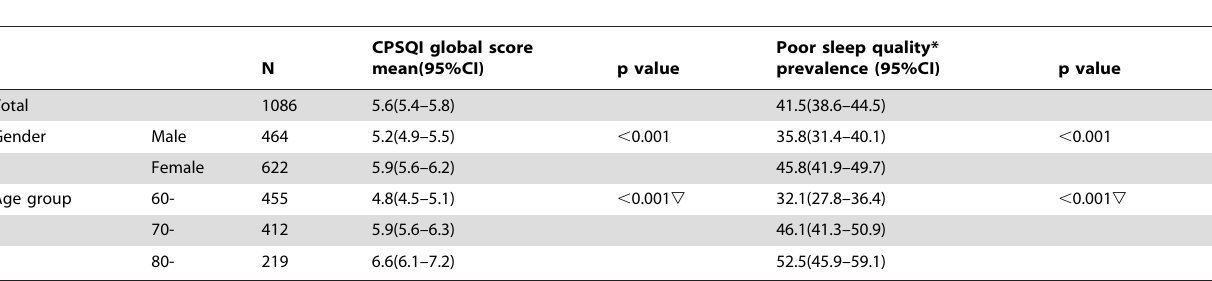
Table 3. The Chinese version of the Pittsburgh Sleep Quality Index global score and prevalence of poor sleep quality of participants by gender and age